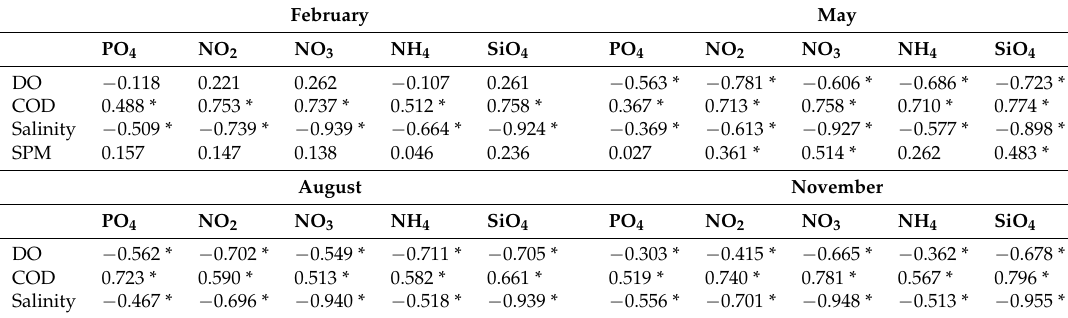
Table 2. Correlations between nutrient concentrations (N, P, and Si) and hydrological factors (dissolved oxygen (DO), chemical oxygen demand (COD), salinity, and suspended particulate matter (SPM)) in the Pearl River estuary (* significant at the 0.05